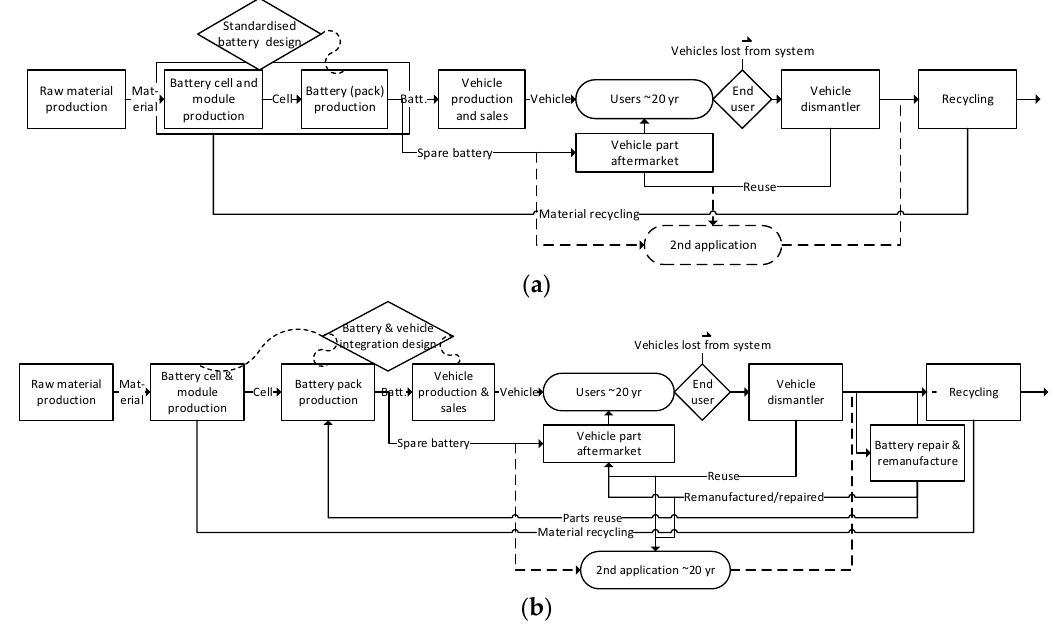
Figure 1. The 3R system for vehicle batteries: ( a ) current system with auxiliary battery (for lead batteries); ( b ) future system with electrical vehicle power batteries (Li-ion).